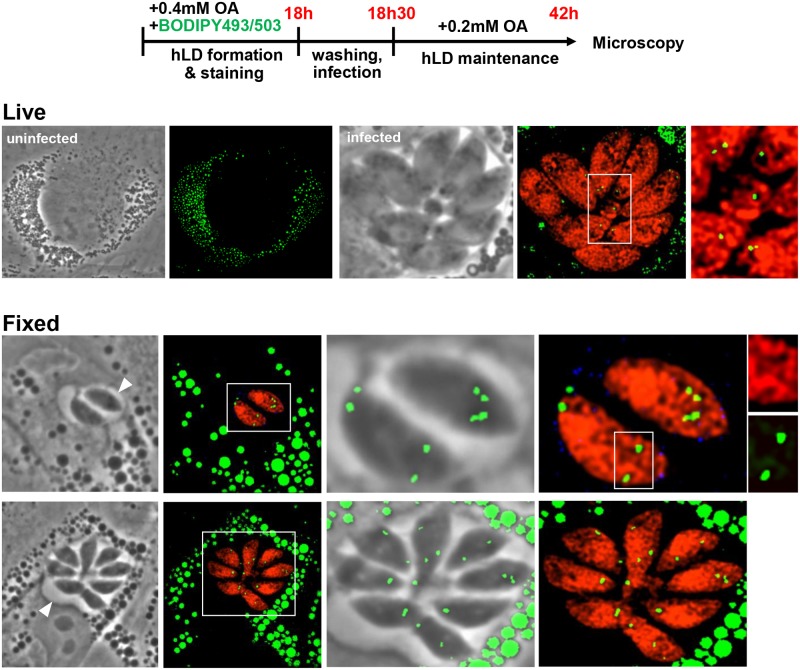
Detection in Toxoplasma of BODIPY 493/503 originated from host LD.Fluorescence microscopy of uninfected or infected HFF with RFP-expressing parasites in the presence of 0.4 mM OA and BODIPY 493/503 (10 μM). Schema outlining the experimental protocols is shown at the top. BODIPY 493/503 (green) was co-administrated with OA for 18 h prior to infection, allowing the storage of BODIPY 493/503 in host LD (hLD). After washing and infection in the presence of 0.2 mM OA, to maintain host LD, for ~24 h, cells were observed by live microscopy (upper panel) or fixed for IFA using anti-GRA7 antibodies (in blue; lower panel). In both cases, the BODIPY 493/503 signal was observed within the parasite both in small and large PV (arrowheads).